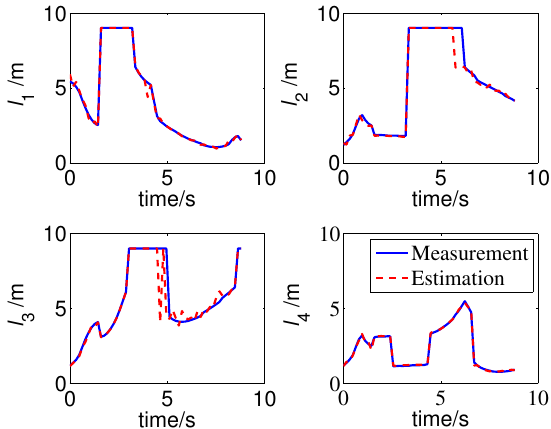
Figure 14. Measurements and multi-ray model estimations of ultrasonic sensors (simulation).